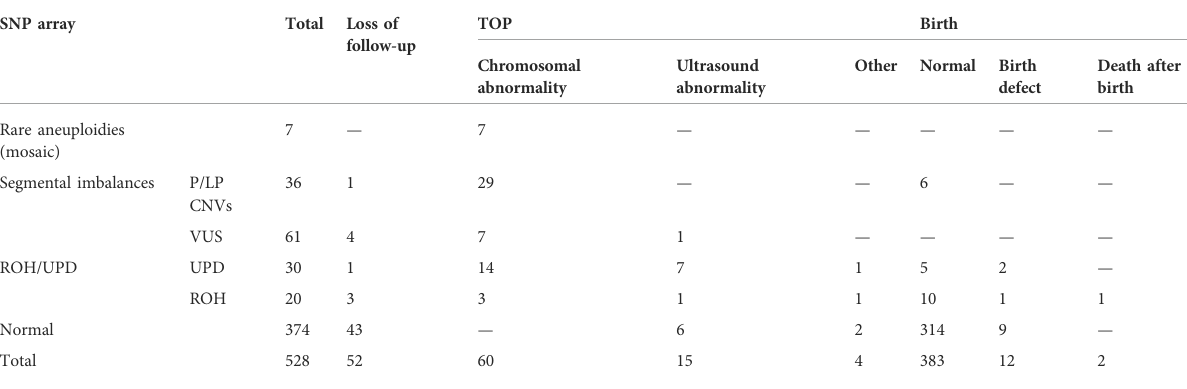
TABLE 3 Clinical follow-up assessment of the 528 fetuses detected by CMA. SNP array Total Loss of